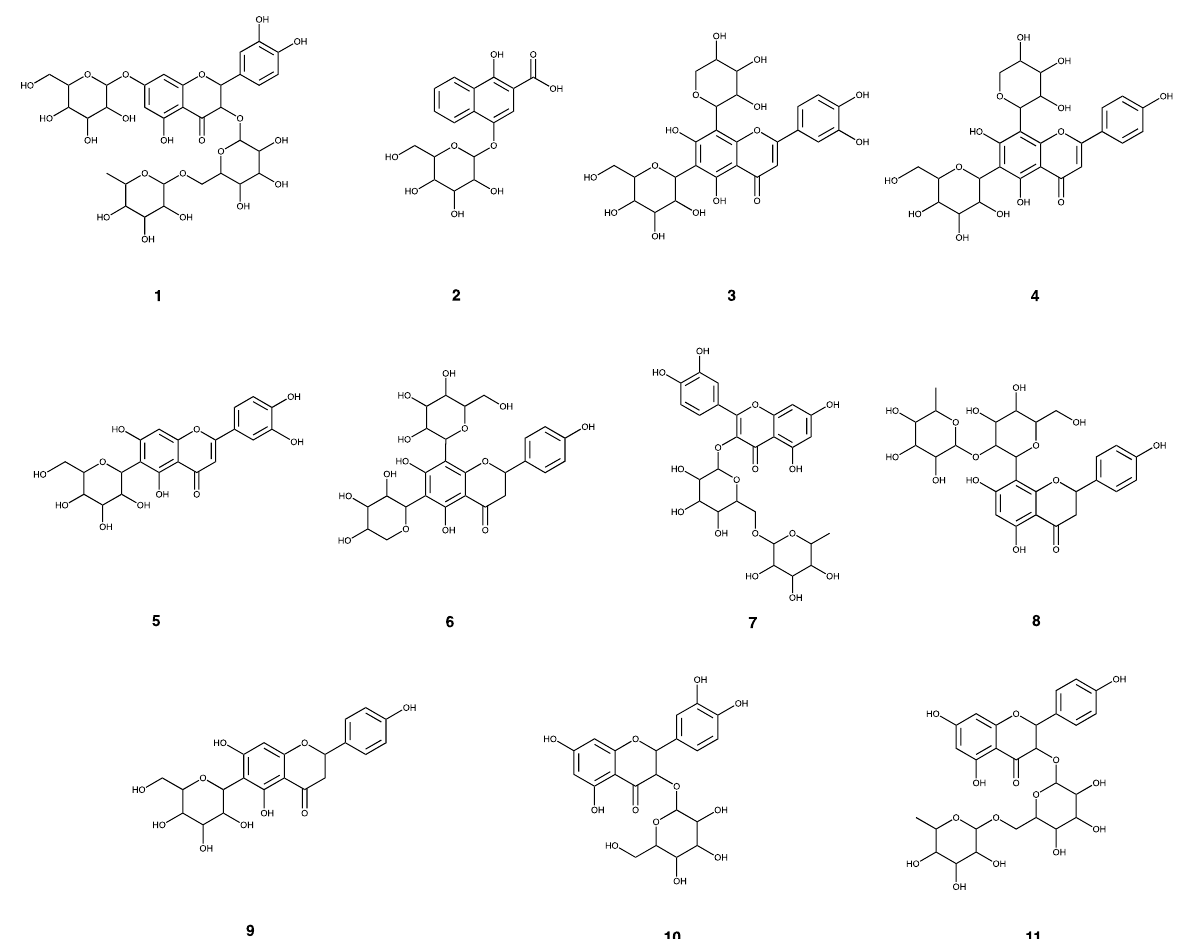
Figure 5. Chemical structures of the compounds identified from fig leaves (refer to Table 5): Compounds 1 through 11 are 3-O- ( rhamnopyranosyl-glucopyranosyl)-7-O-(glucopyrnosyl)-quercetin; 2-carboxyl-1,4-naphthohydroquinone- 4-O-hexoside; luteolin 6-C-hexoside, 8-C-pentoside; kaempferol 6-C- hexoside -8-C-hexoside; quercetin 6-C- hexobioside; kaempferol 6-C- hexoside -8-C-hexoside; quercetin 3-O- hexobioside; apigenin 2″ -O-pentoside; apigenin 6-C-hexoside; quercetin 3-O-hexoside; kaempferol 3-O-hexobioside. Table 5. Flavonoids identified in the fig leaf extracts using UPLC-QTOF-MS/MS. Peak No.